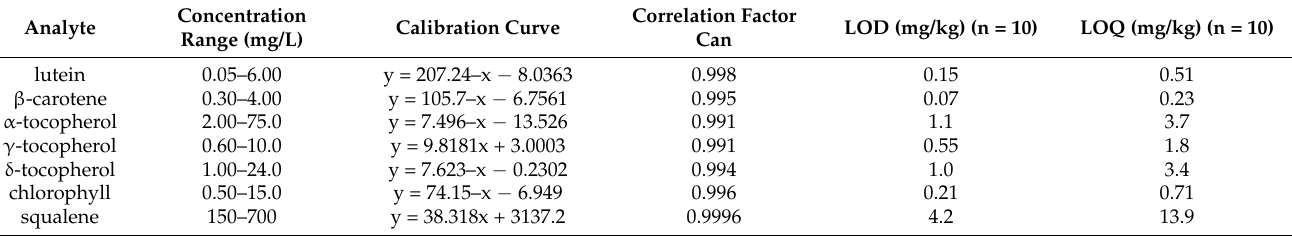
Table 3. Concentration range, Calibration curves, correlation coefficients, LODs and LOQs of each analyte studied.